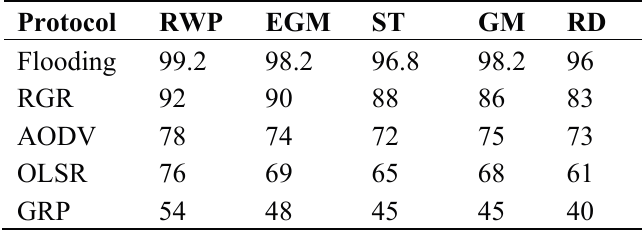
Table 3. Ranking of routing protocols’ PDR (%) over different mobility